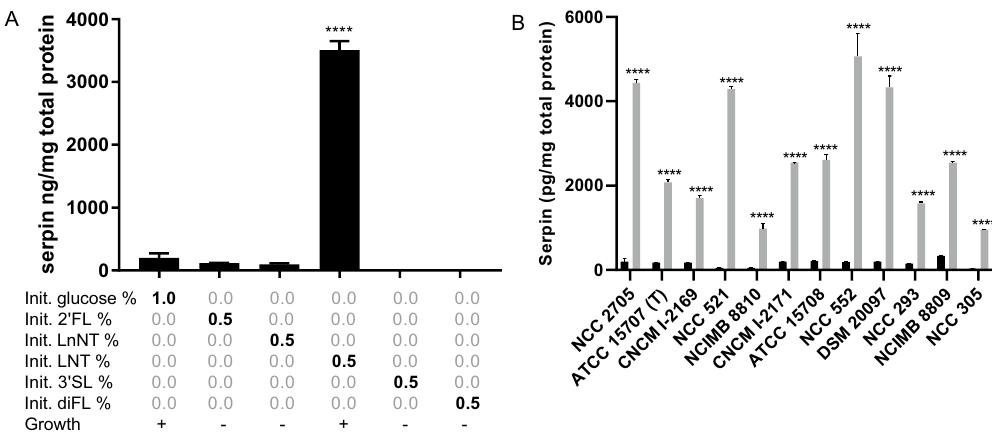
Figure 6. Serpin concentrations in extracts of B. longum NCC 2705 grown to the stationary phase (16 h) on MRSc medium, supplemented with the human milk oligo-saccharides (2 ′ -O-Fucosyllactose [2 ′ FL], Lacto- N-neotetraose [LNnT], Lacto-N-tetraose [LNT], 3 ′ -O-Sialyllactose [3 ′ SL], Difucoxyllactose [DiFL]) (panel A). Different B. longum subsp. longum strains grown to stationary phase(16 h) on MRSc supplemented with 1% glucose (black bars) or 0.5% LNT (grey bars) (panel B). Bars represent means and standard deviations are depicted. P -values represent statistical difference to the glucose control groups. **** p <